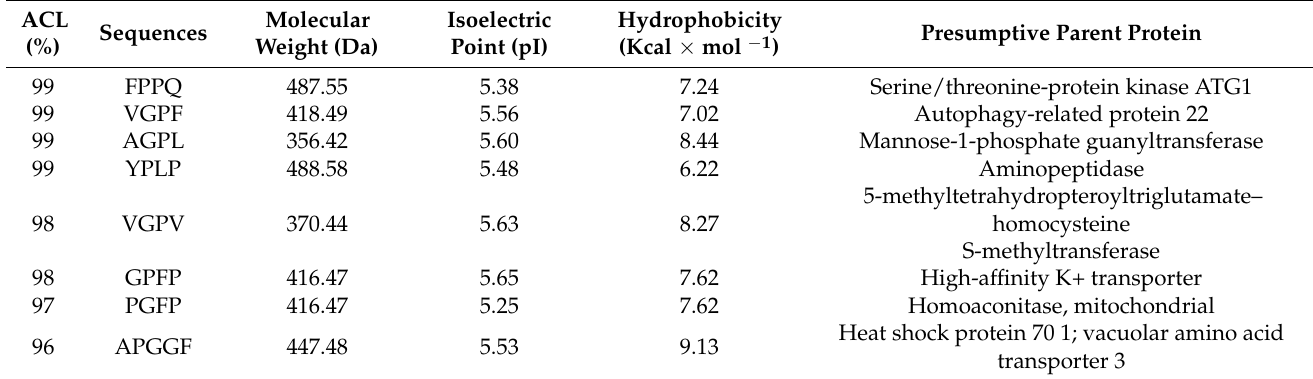
Table 3. Sequence composition and properties in the AP-D10